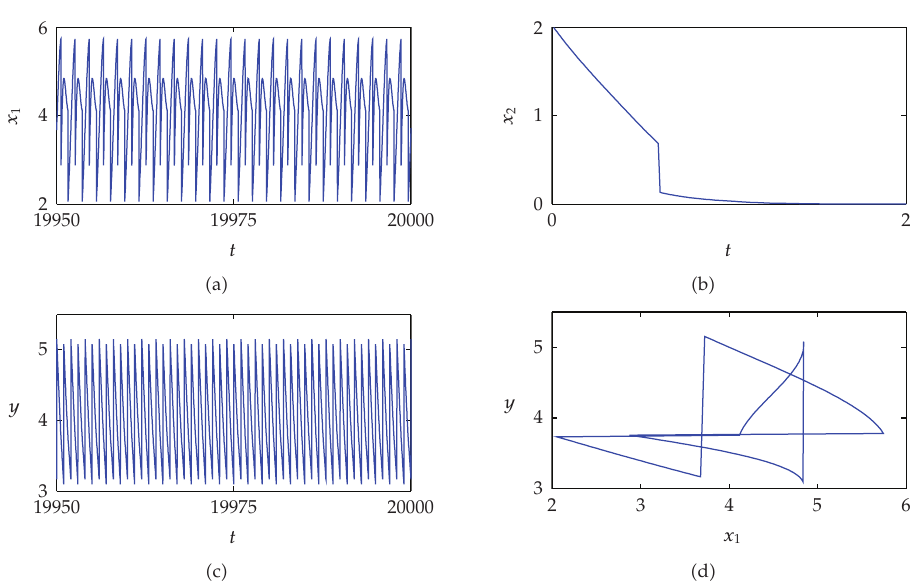
Figure 3: (cid:3) a (cid:4) – (cid:3) c (cid:4) Time series. (cid:3) d (cid:4) The trajectory of system (cid:3) 1.2 (cid:4) with an initial value (cid:3) 2 , 3 , 1 (cid:4) .